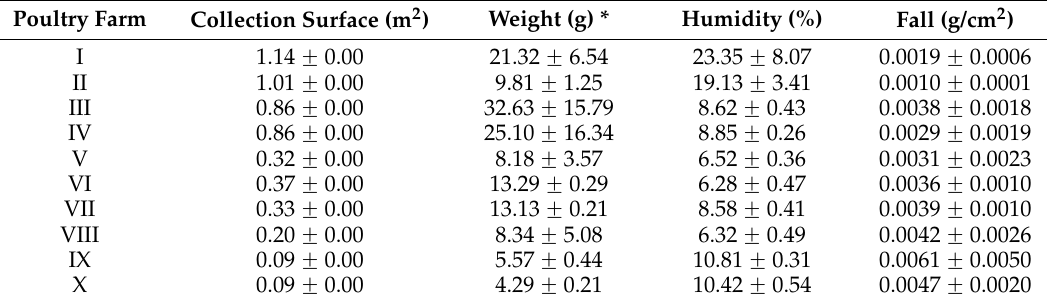
Table 2. Settled dust sample